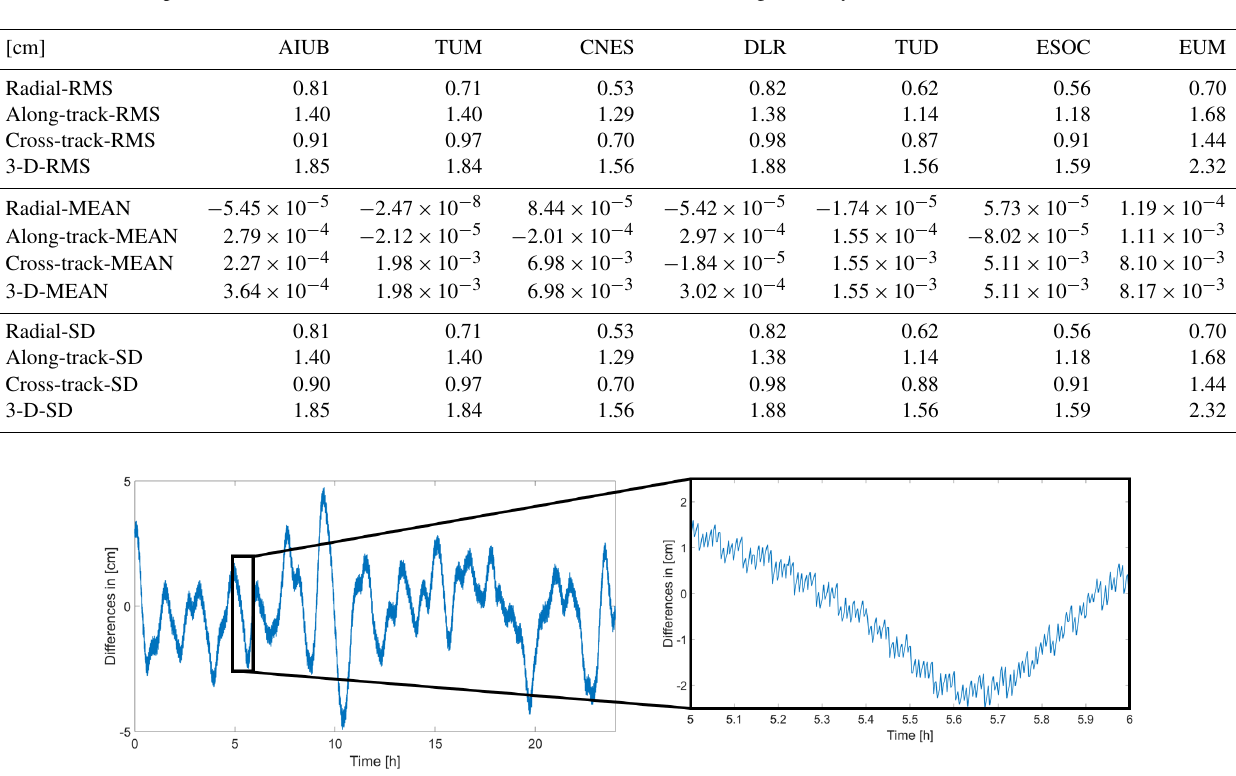
Table 3. Orbit comparison in the local orbital frame, CPOD vs. other solutions, average of daily values.